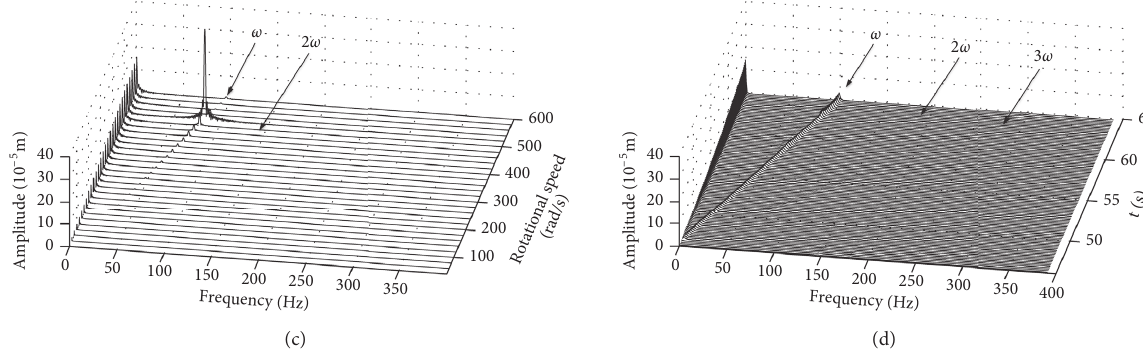
Figure 8: Waterfall spectra plots for the vibration of disk 3 during hovering. (a) Horizontal response, numerical simulation. (b) Horizontal response, experimental results. (c) Vertical response, numerical simulation. (d) Vertical response, experimental results.